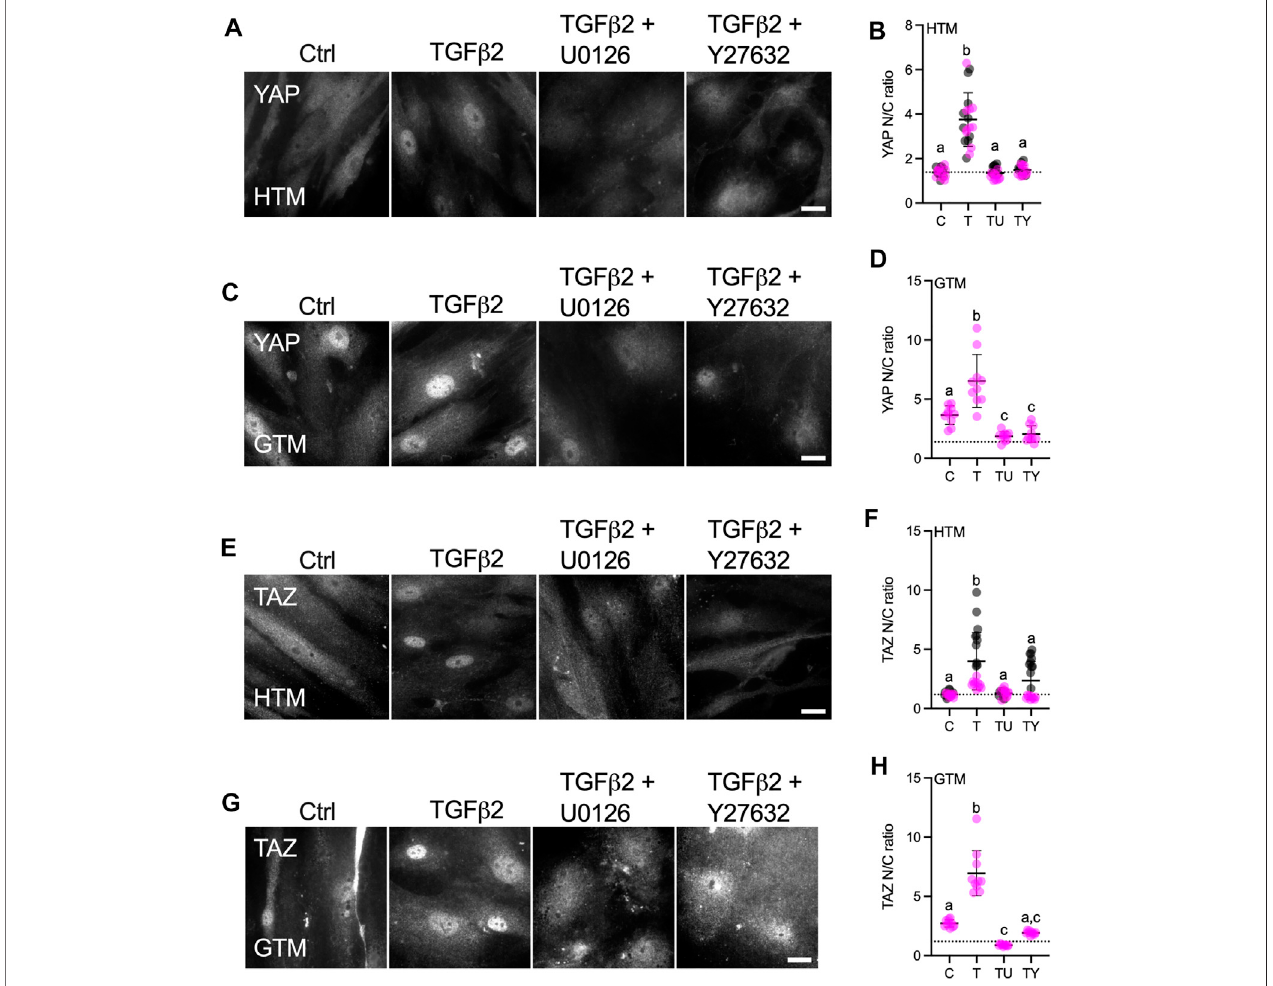
FIGURE3| Effects ofTGF β 2inabsenceorpresence ofERK orROCKinhibition on nuclear YAP/TAZ localizationin HTMand GTMcells. (A,C,E,G) Representative fl uorescence micrographs of YAP or TAZ in HTM or GTM cells on soft hydrogels subjected to control, TGF β 2 (2.5 ng/ml), TGF β 2 + U0126 (10 µM), TGF β 2 + Y27632 (10 µM)at3 days(YAP=grey).Scalebar,20 μ m. (B,D,F,H) AnalysisofYAPorTAZnuclear/cytoplasmicratio( n =20imagesfrom2HTMcellstrainswiththreereplicates percellstrain; n =10imagesfromoneGTMcellstrainwiththreereplicates).Symbolswithdifferentcolorsrepresentdifferentcellstrains;dottedlineshowsHTMcell control mean value for reference. The lines and error bars indicate Mean ± SD. Signi fi cance was determined by one-way ANOVA using multiple comparisons tests [shared signi fi cance indicator letters represent non-signi fi cant difference ( p > 0.05), distinct letters represent signi fi cant difference ( p < 0.05)].